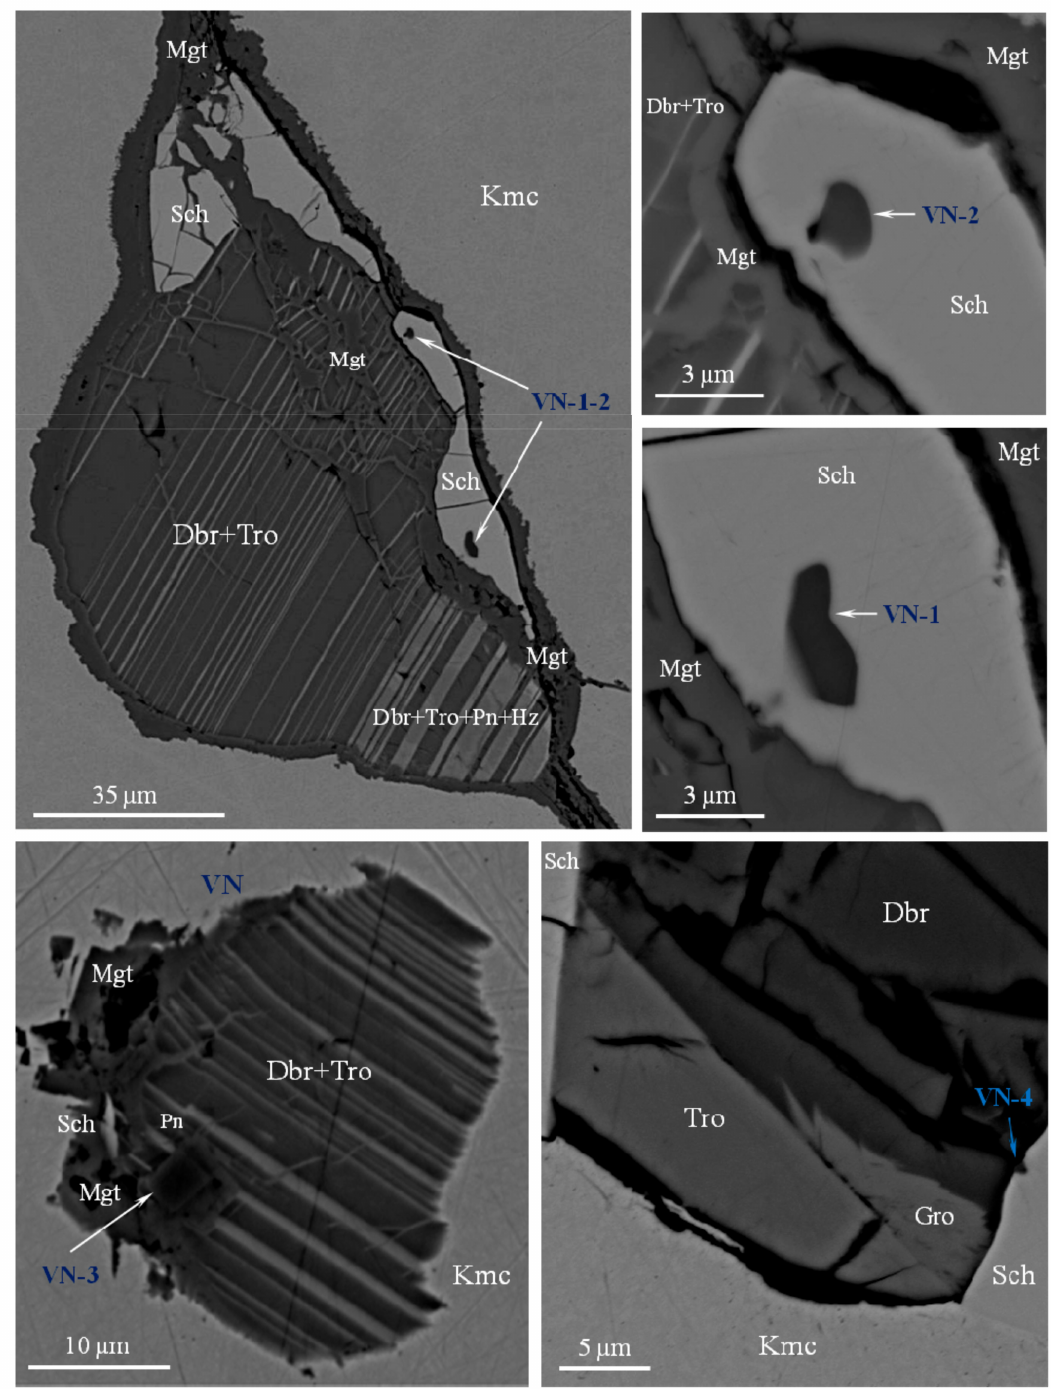
Figure 5. Uakitite in troilite–daubr é elite ± schreibersite globules in Fe-Ni-metal (kamacite), Uakit meteorite (IIAB), BSE images. Symbols: VN-1–VN-4—uakitite (see also Figure